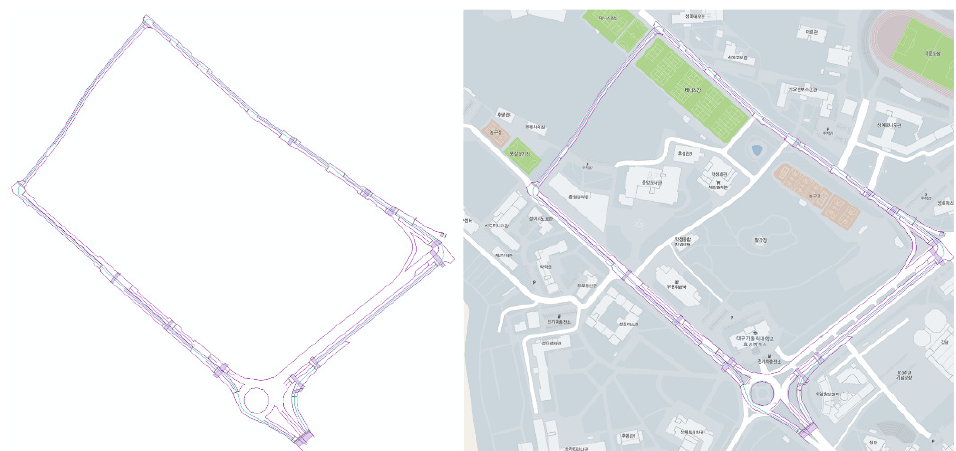
Figure 12. Dynamic high-definition map result at a university.